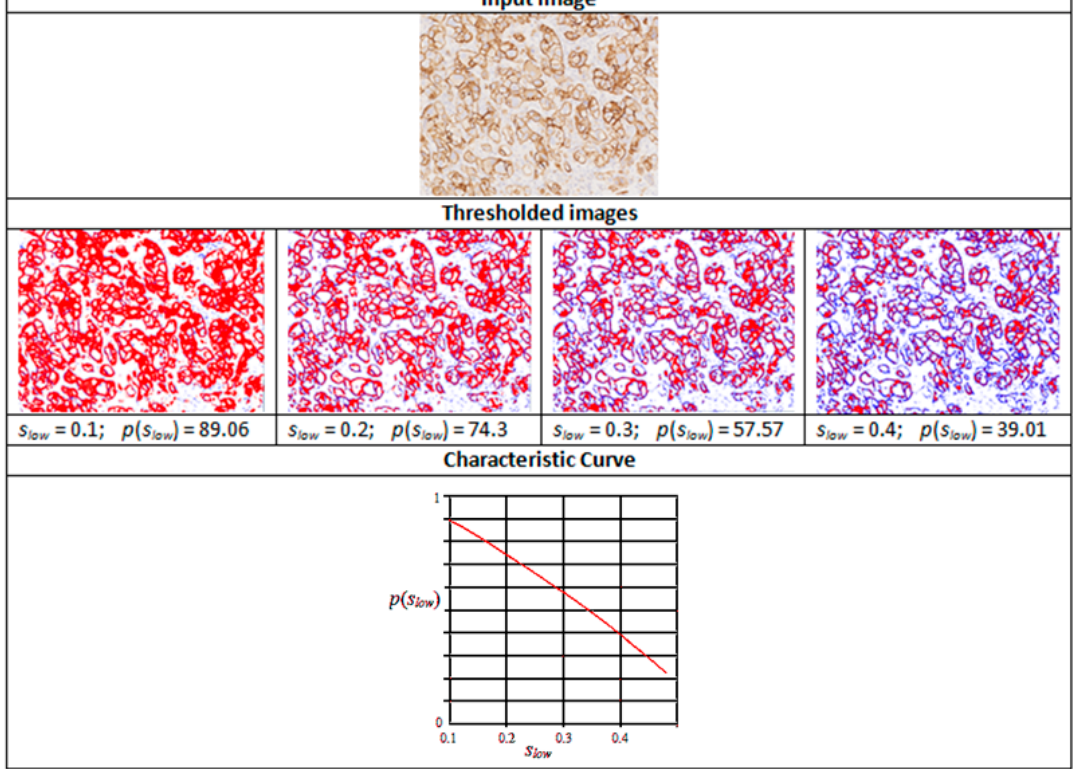
Figure 3. Intermediate stages in the generation of a characteristic curve. Reproduced from [12] with permission.